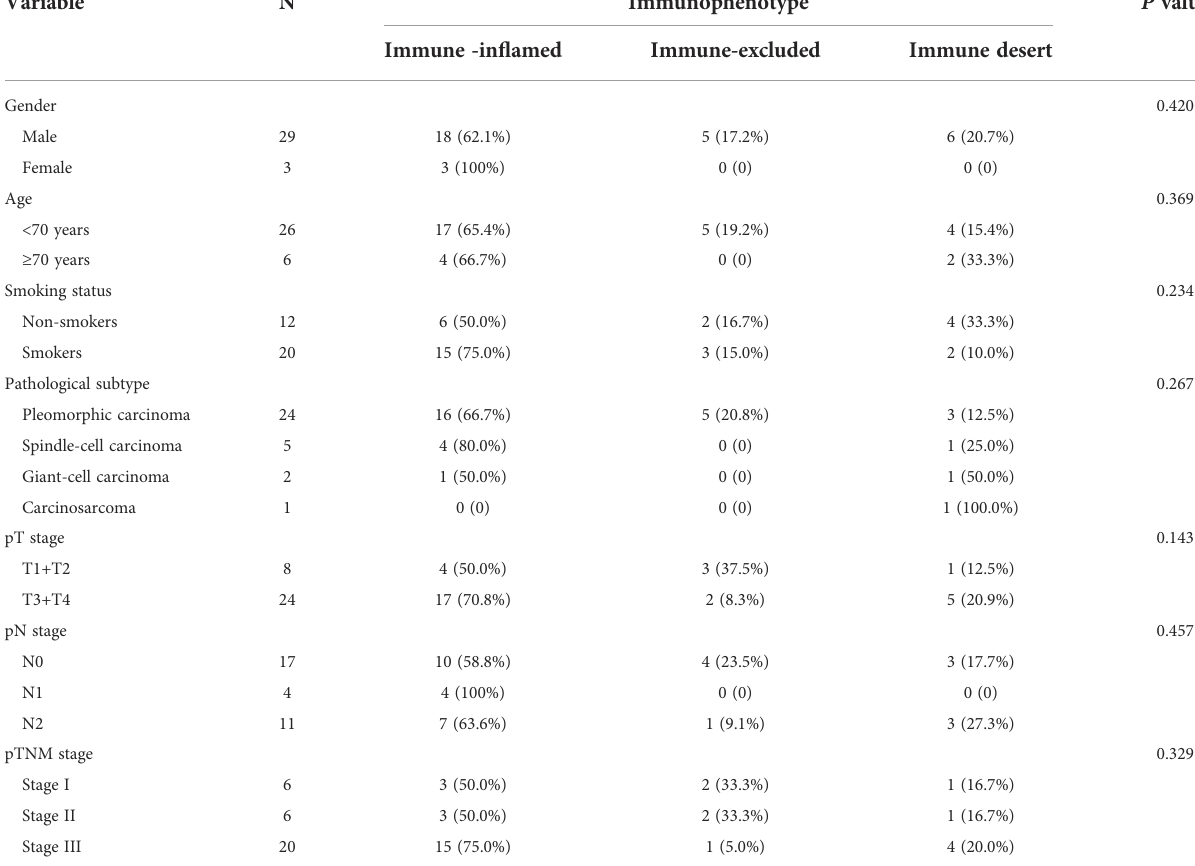
TABLE 4 Immunophenotyping of PSC based on CD8+ T cell in fi